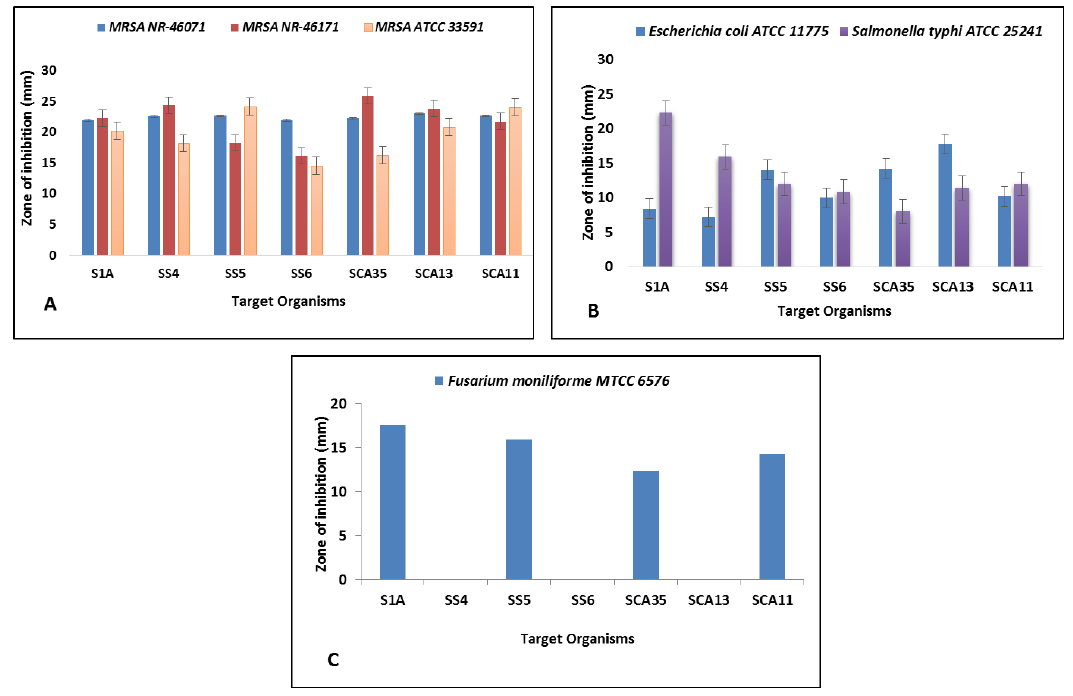
Figure 6. Antimicrobial activity of actinobacterial isolates against ( A ) MRSA ATCC NR 46071, MRSA ATCC NR 46171, and MRSA ATCC 33591 ( B ) Escherichia coli ATCC 11775 and Salmonella typhi ATCC 25241, ( C ) Fusarium moniliforme MTCC 6576. Table4. Minimuminhibitoryconcentration(MICin µ g / mL)ofactinobacterialisolatesagainstpathogenic test organisms.